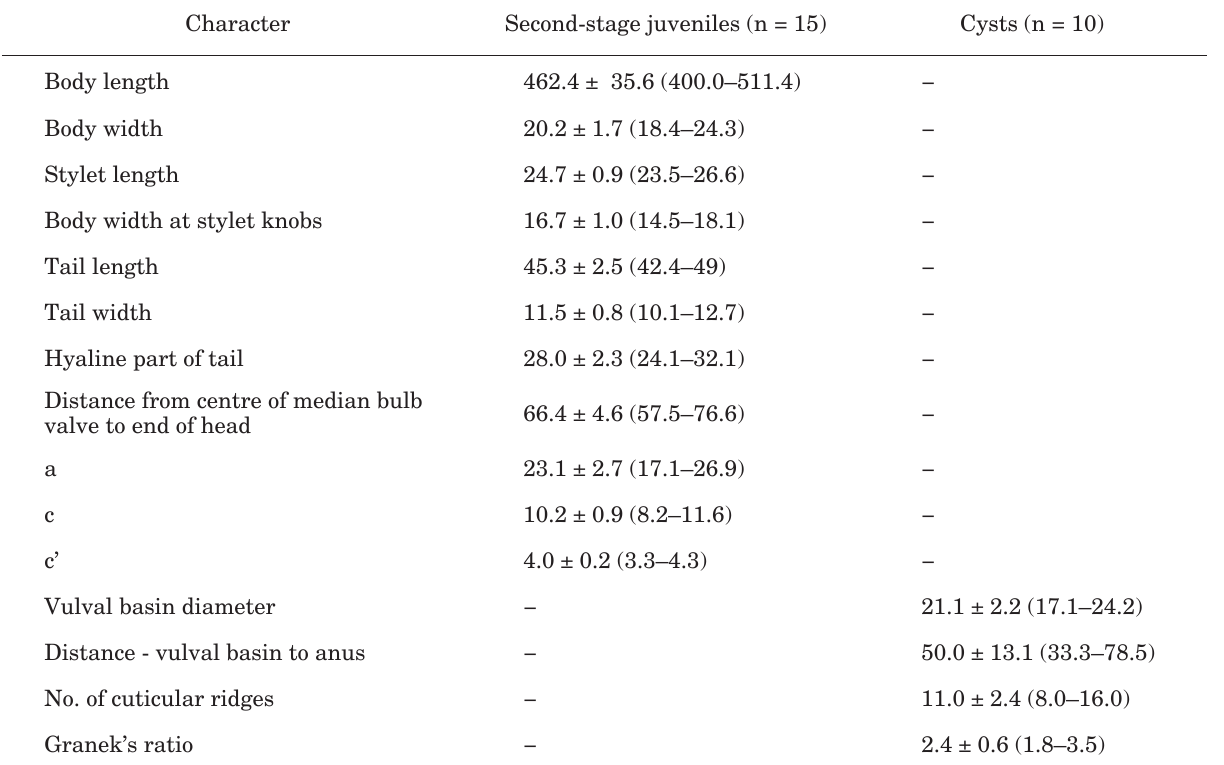
Table 2. Morphometrical characters of second-stage juveniles and cysts of a Globodera pallida sample from Italy. All measurements are in µm, presented as mean ± standard deviation, with the range in